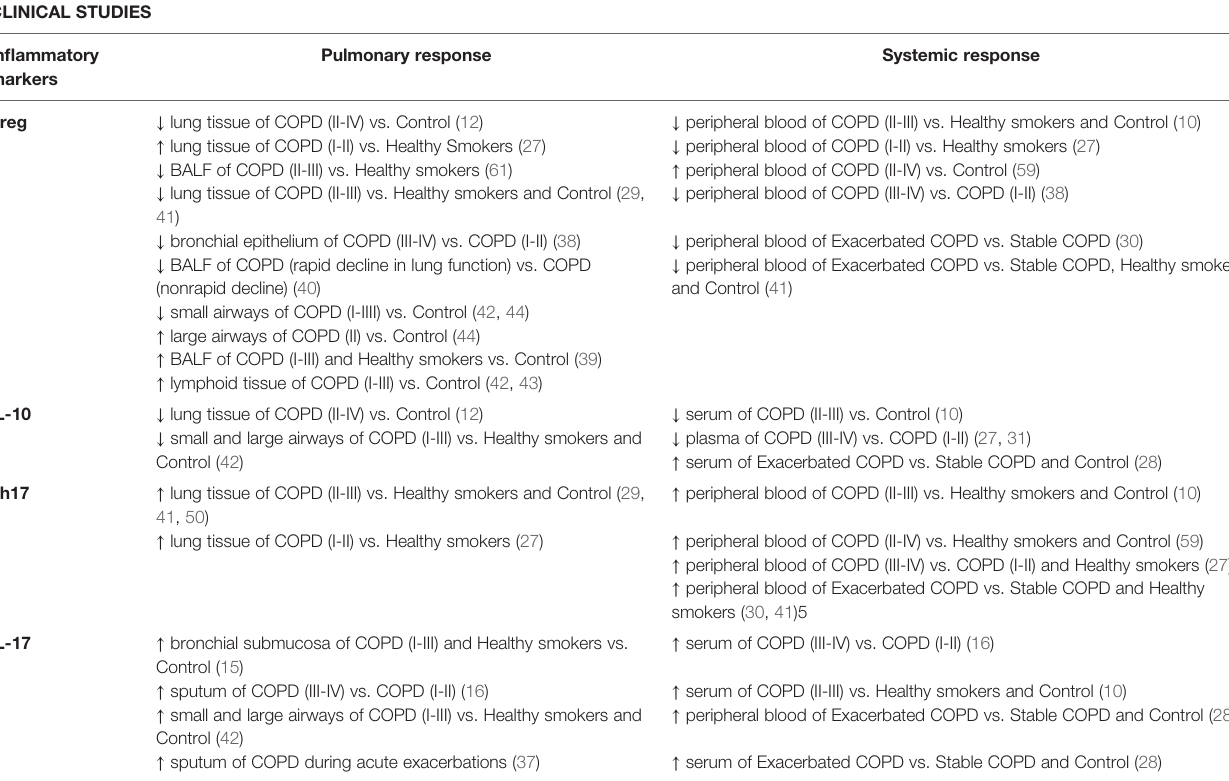
TABLE 1 | Summary of the main fi ndings regarding Th17/Treg imbalance in clinical